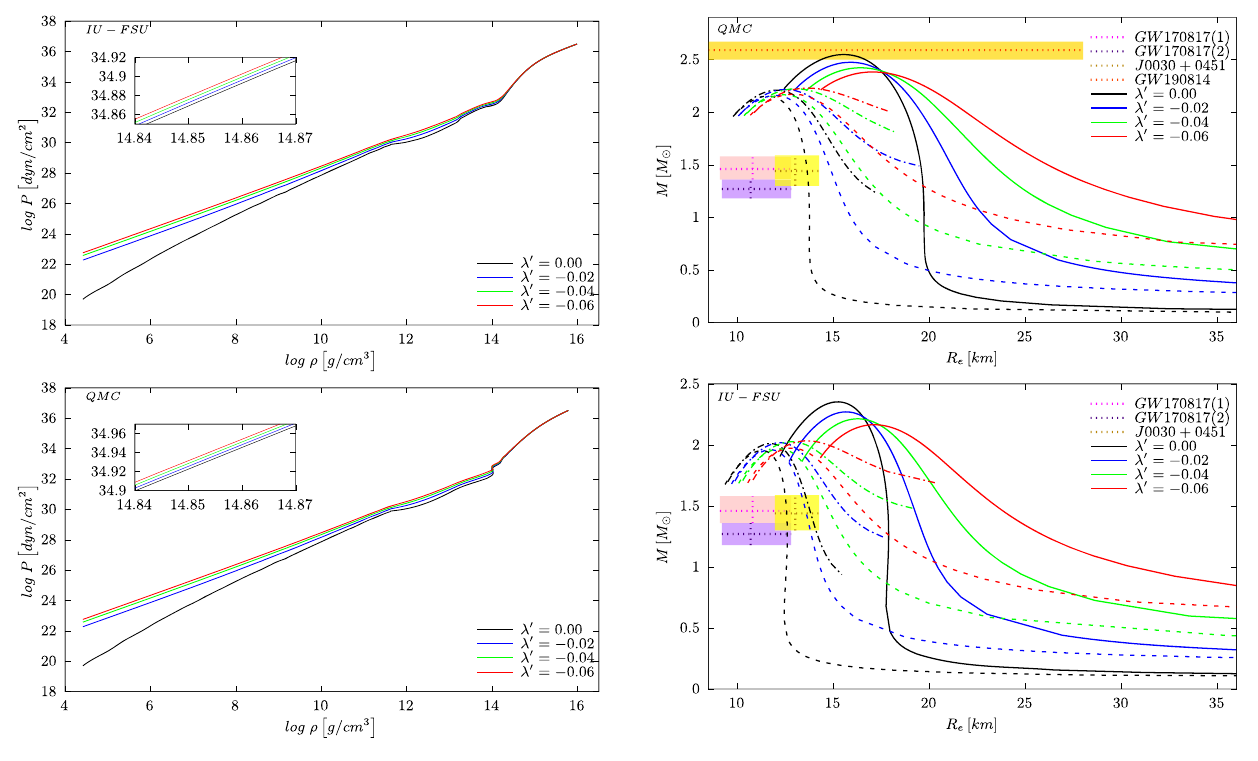
Fig. 1 The relation between the effective pressure and the effective energy density in Log–Log scale. The curves for λ (cid:6) = 0 correspond to the GR case